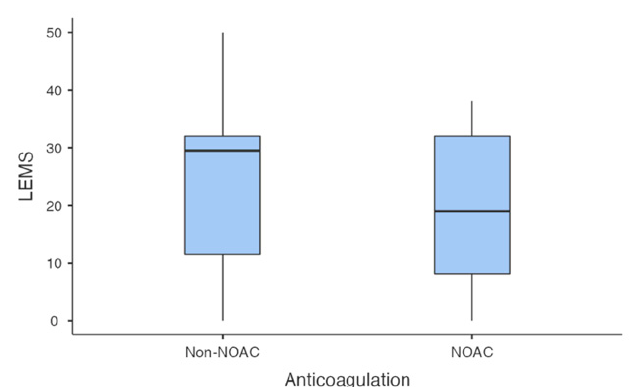
Figure 1. The lower-extremity motor score in the non-NOAC and NOAC treatment groups. There was no statistically significant difference between the two groups. NOAC, non-vitamin K antagonist oral anticoagulant.